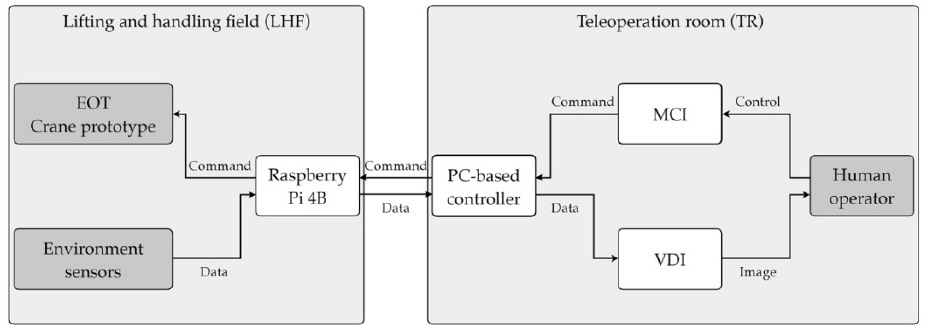
Figure 4. The system set-up diagram.